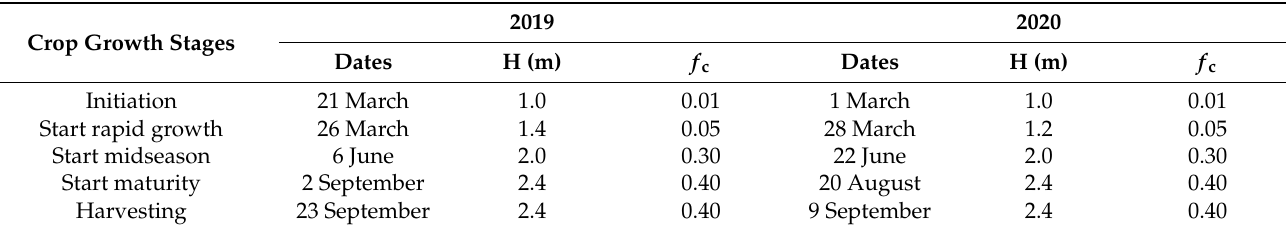
Table 2. Vineyard crop growth stages, height (h), and fraction of the soil covered by the crop in the vineyard ( f c ). Crop Growth